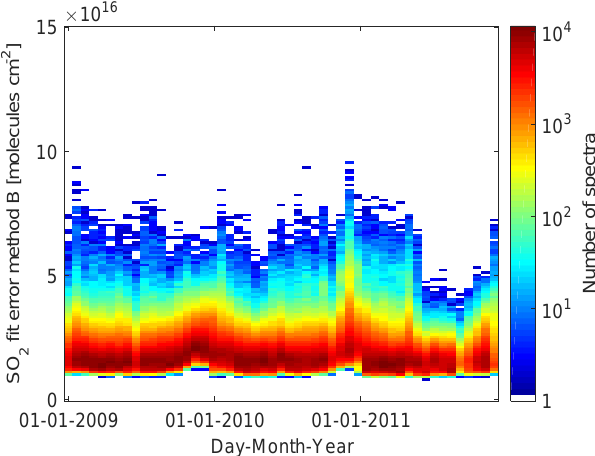
Figure 11. Two-dimensional histogram of the SO 2 DOAS fit error from the solar atlas evaluation as a function time for instrument D2J2201 (Nevado del Ruiz).